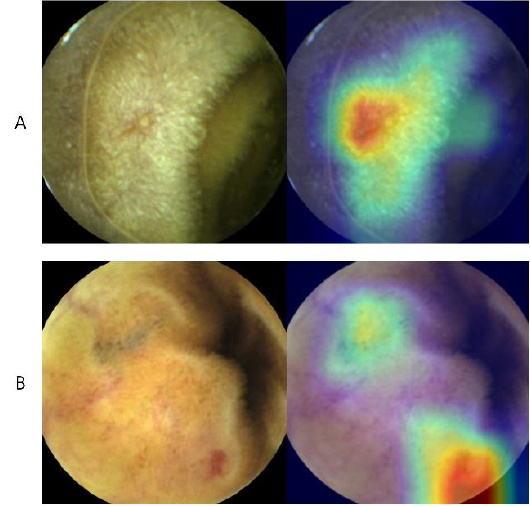
Figure 2. CNN’s class activation map (CAM) in capsule endoscopy image reading. This visualized feature map describes how the algorithm predicts each lesion. ( A ) Erosion with central depression of the mucosa is highlighted as red. ( B ) Simultaneous detection of both erosion and prominent vas- culature.